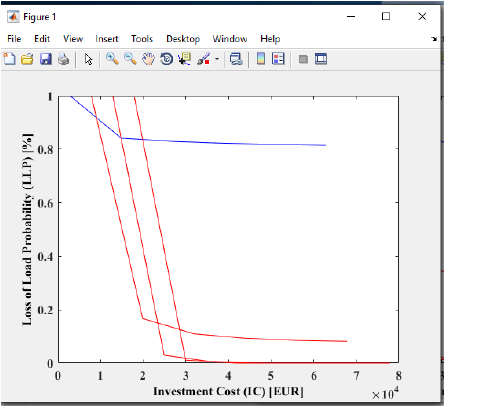
Figure 11. Irradiation and Load at average day and its cost in Euro